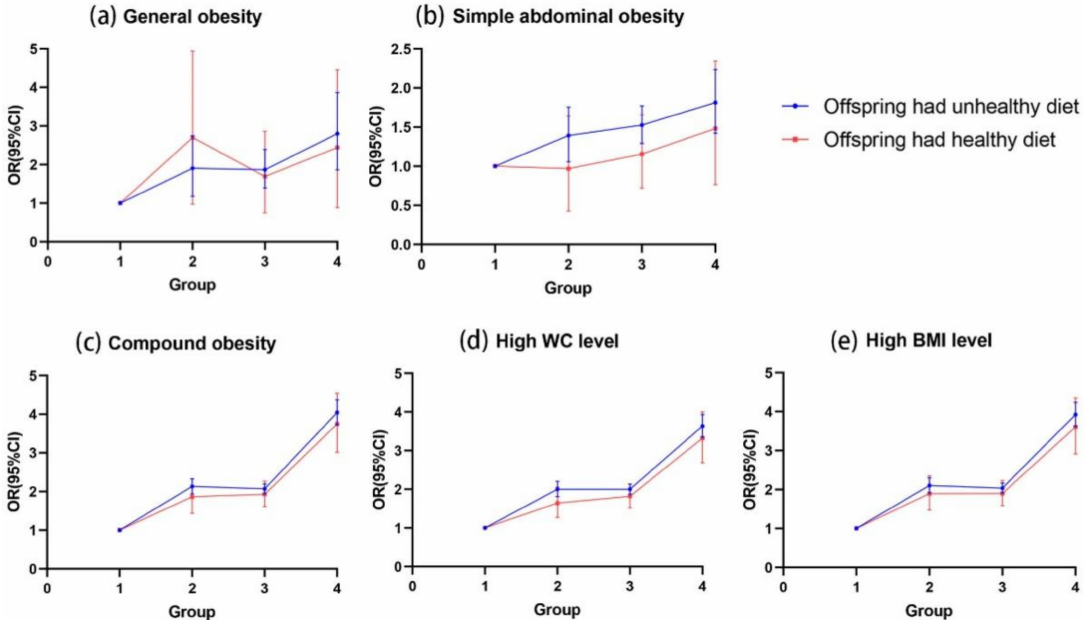
Figure 3. Association of OW/OB between parents and offspring, stratified by their offspring’s dietary behaviors. Notes: Adjust for offspring age, sex, resident area, single-child status, breastfeeding, parental highest educational attainment, parental SSBs consumption, meat consumption, breakfast eating, and fast food consumption. Group 1, offspring with no parental OW/OB; Group 2, offspring with only maternal OW/OB; Group 3, offspring with only paternal OW/OB; Group 4, offspring with both parental